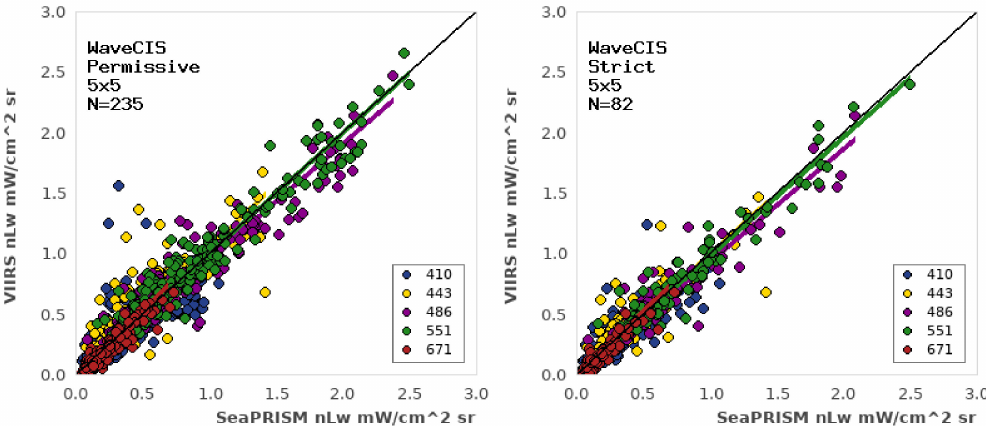
Figure 3. WaveCIS SeaPRISM vs. VIIRS comparison, June 2014–May 2019. Left: permissive protocol; right: strict protocol. The number of match-ups decreased by 65% when applying the strict constraints. Note that in the presented scatter plots there is a black 1:1 line shown for reference purposes, and the colors represent 410, 443, 486, 551, and 671 nm,